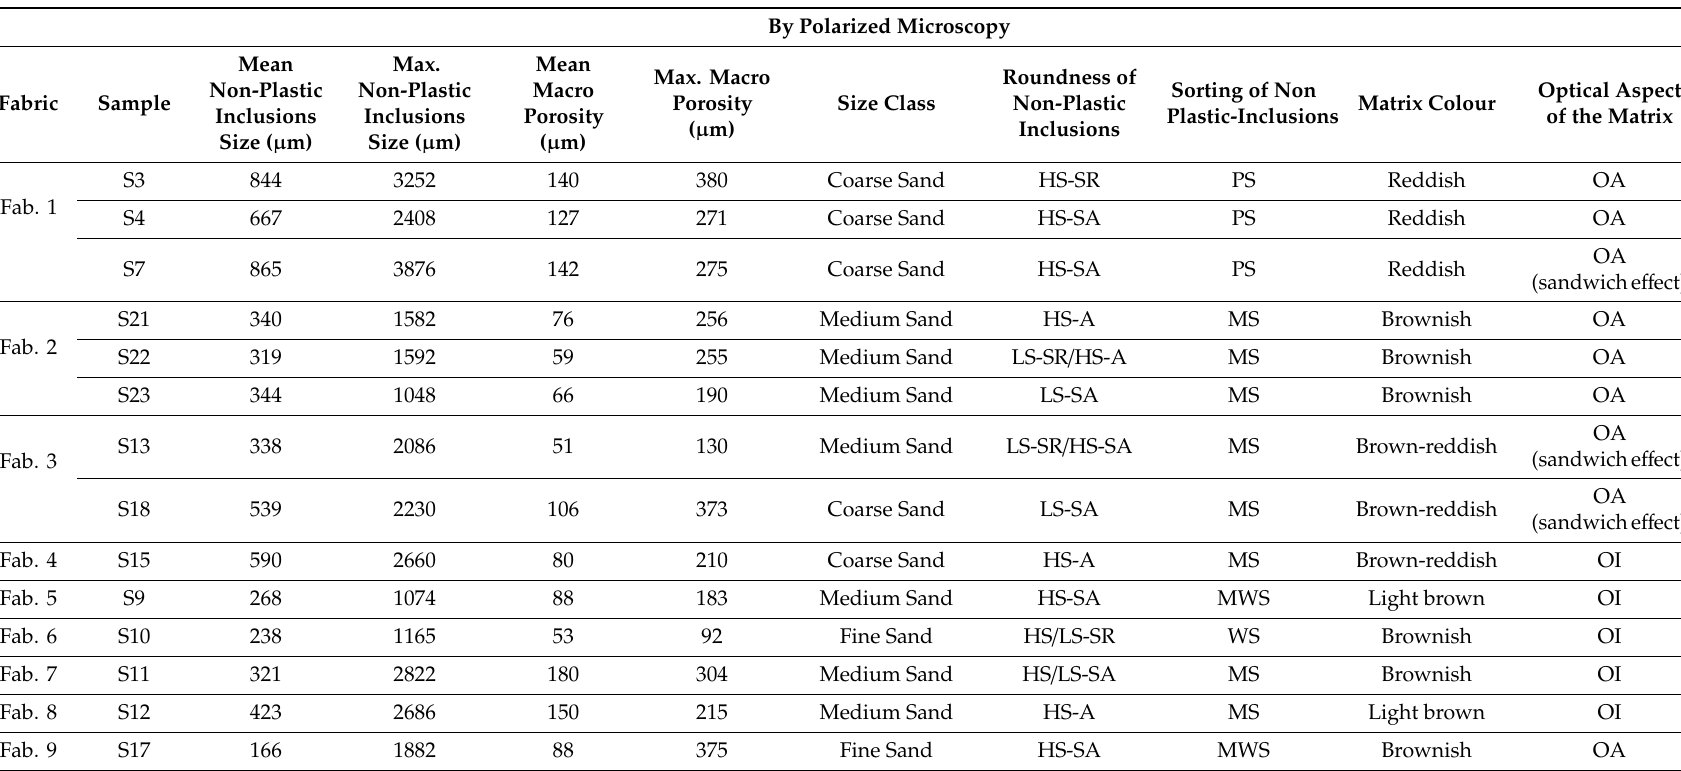
Table 2. Petrographic features of the architectural earthenwares by optical microscopy. (Roundnsess = HS: high sphericity, LS: low sphericity, A: angular, SA: sub-angular, SR: sub-rounded. Sorting = MS: moderately sorted, MWS: moderately well sorted, PS: poorly sorted, WS: well sorted. Optical aspect of the matrix = OA: optically active; OI: optically